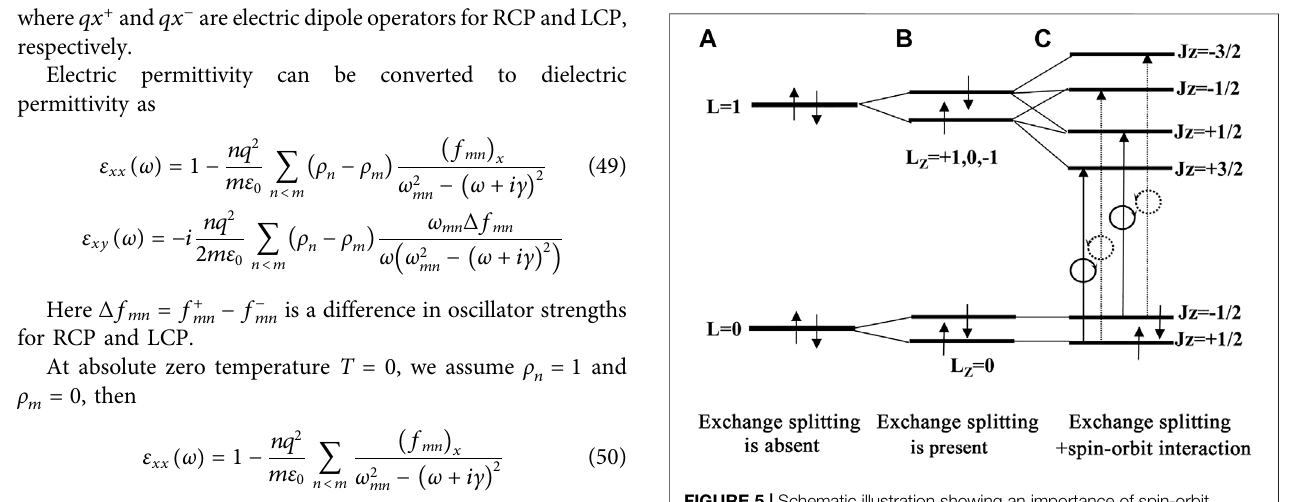
FIGURE 5 | Schematic illustration showing an importance of spin-orbit interaction for magneto-optical effect to occur. (A) exchange splitting is absent, (B) exchangesplittingispresent,and (C) exchangesplittingandspin- orbit interaction are present.